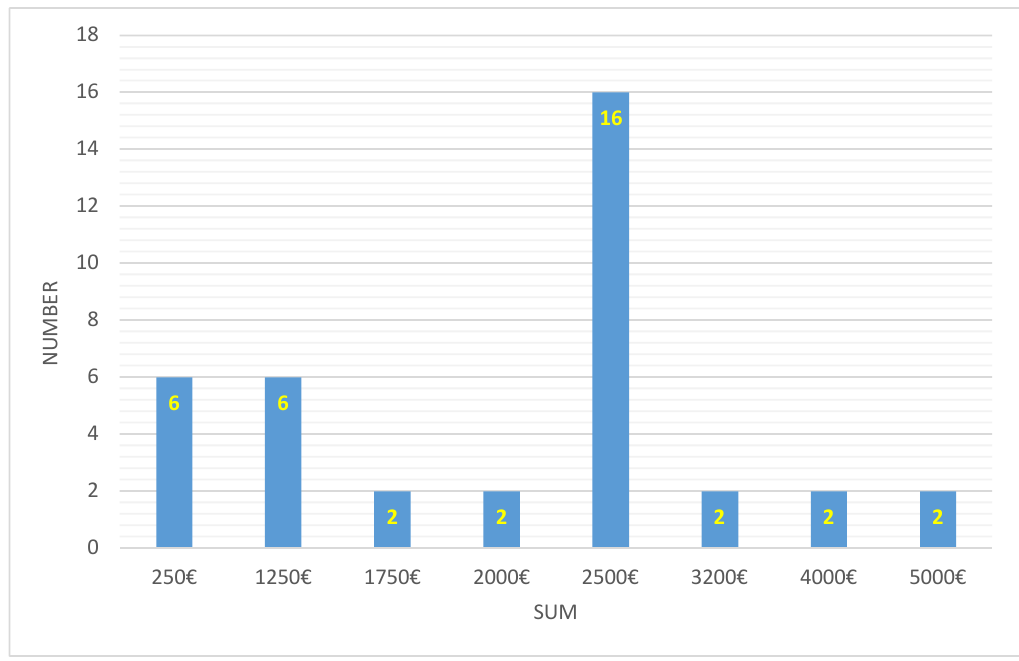
Figure 2. The distribution of Red Cross funding of treatment in interviewed PCHD families (n = 38).